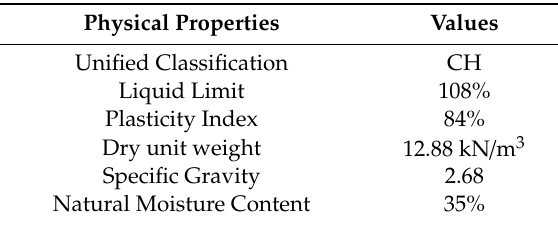
Table 1. Yazoo clay soil